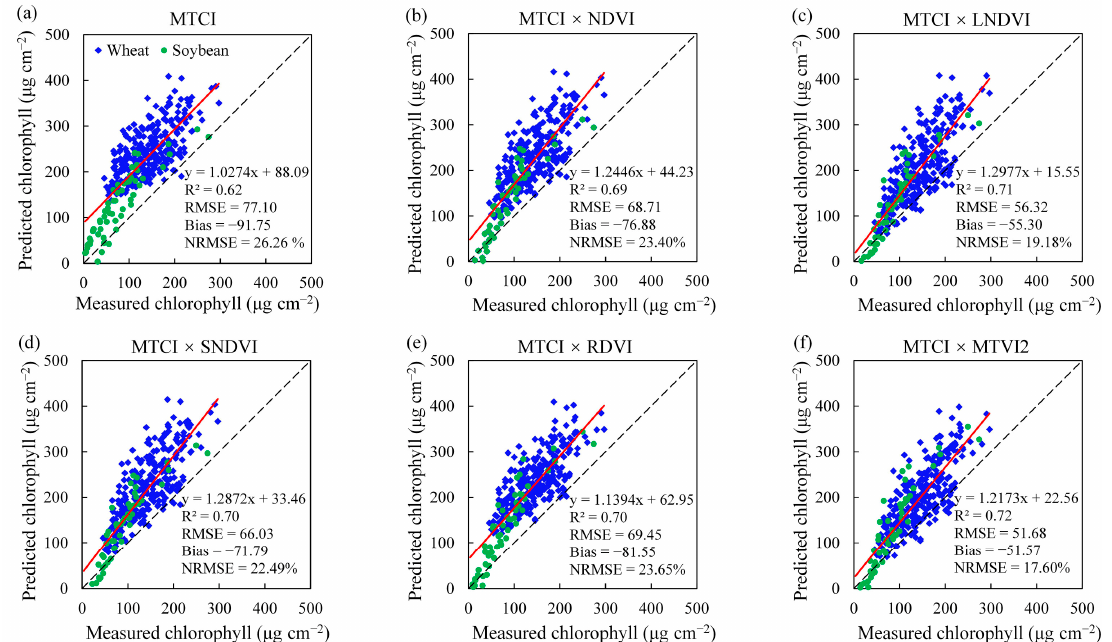
Figure 7. The CCC retrieval accuracy for soybeans and wheat when using the ULR method with field spectrum data: ( b ) MTCI × NDVI; ( c ) MTCI × LNDVI; ( d ) MTCI × SNDVI; ( e ) MTCI × RDVI; ( f ) MTCI × MTVI2. The performance of a single MTCI in a linear regression model is displayed in ( a ) for comparison.